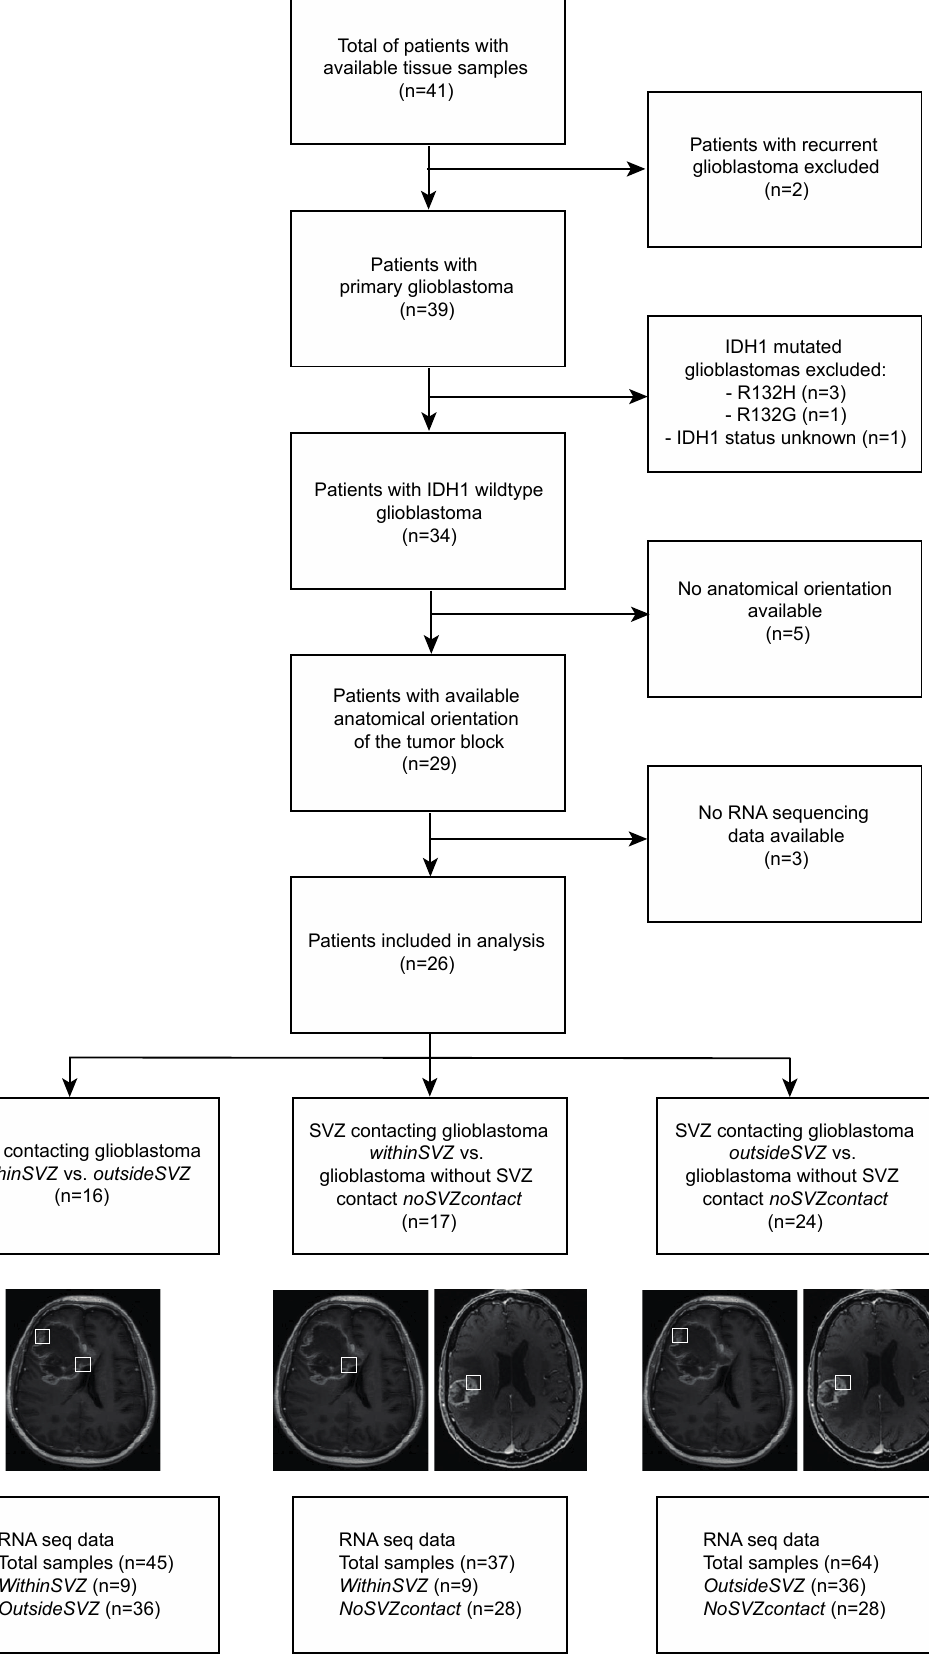
Figure 1. Flowchart. Figure 1.